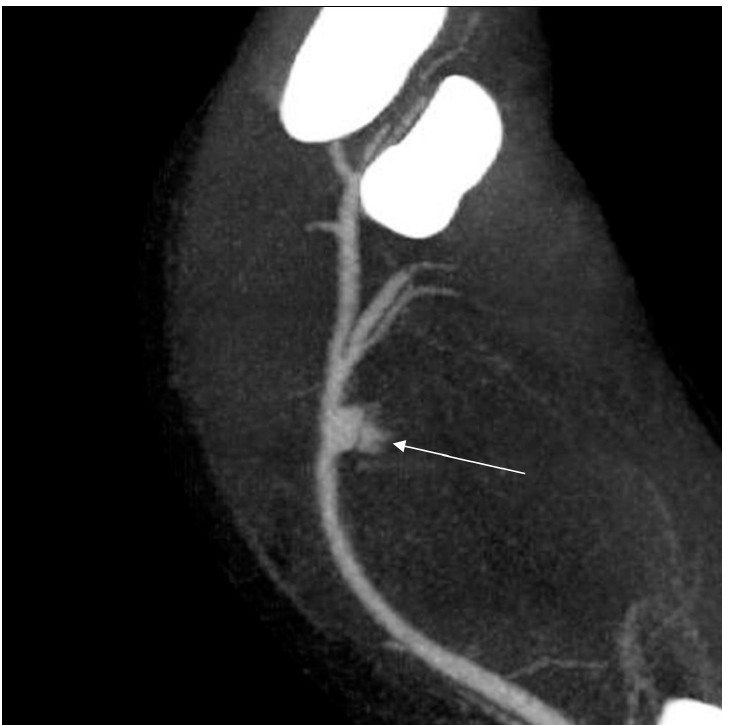
Figure 2. Right upper limb computed tomography angiography. MIP reconstruction. Leakage of the contrast agent beyond the lumen was found, consistent with active bleeding from the injured brachial artery.